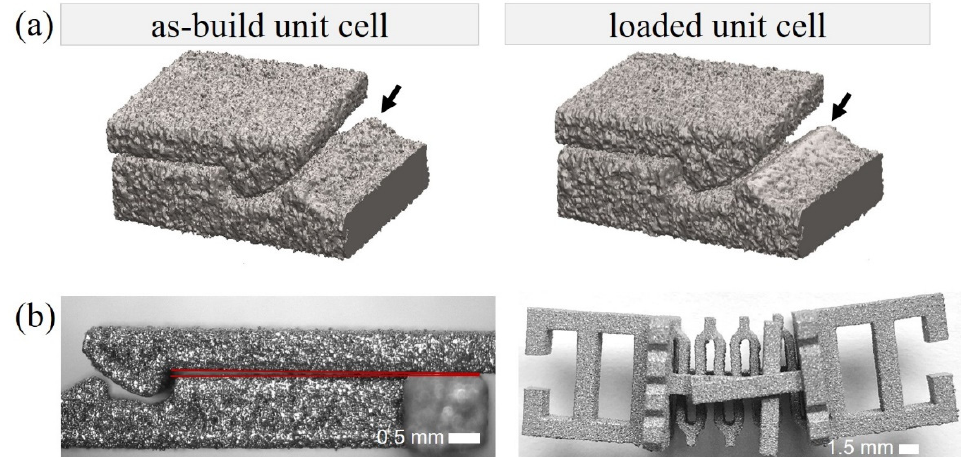
Figure 4. CT-reconstructions and optical micrographs of different sample variations induced by manufacturing or experiments. ( a ) Reconstruction of CT-scans of a V2.2 snap-fit as-built ( left ) and a loaded ( right ). ( b ) Representative optical micrographs showing distortion of the manufactured unit cell.